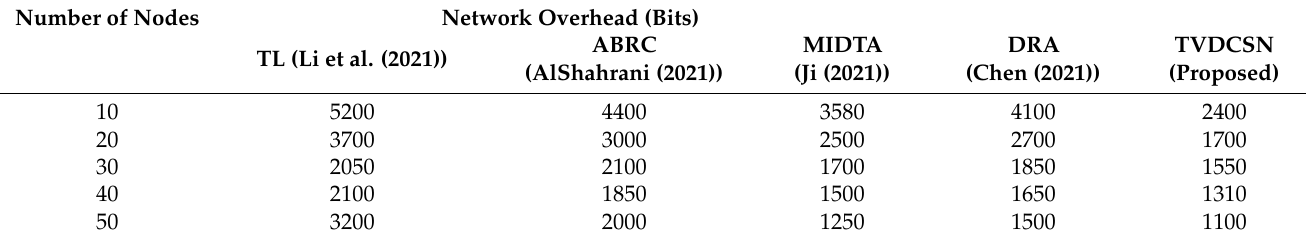
Figure 9. Proposed and existing methods of network overhead. Figure 8. Proposed and existing methods of network overhead. Table 4. Values of proposed and existing methods network overhead . Table 4. Values of proposed and existing methods network